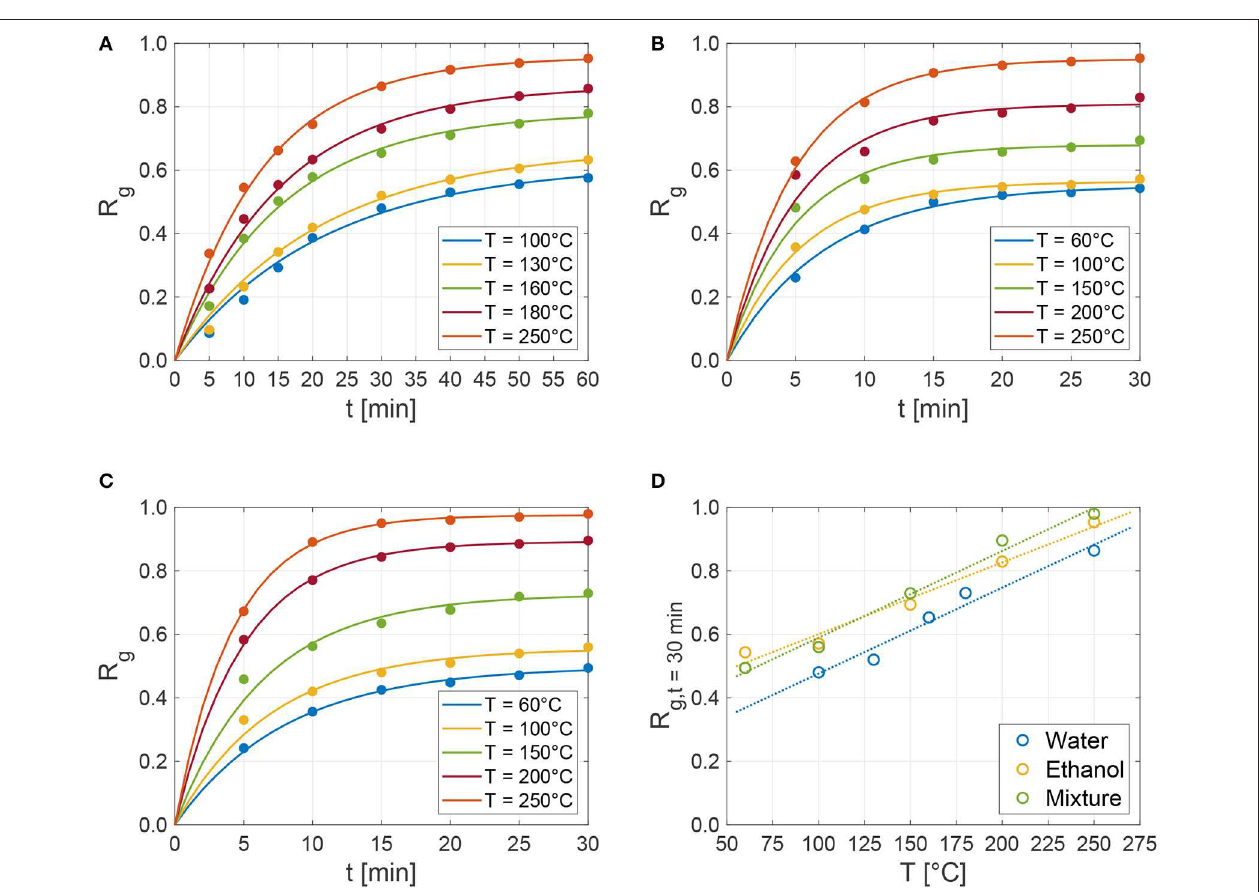
FIGURE 3 | Regeneration grade ( R g in Equation 2) as a function of time obtained by the experimental characterization tests on the 13X zeolite samples at different controlled temperatures for (A) distilled water, (B) ethanol, and (C) 30:70%wt. ethanol-water mixture. The dots correspond to the experimental data points, while solid lines show the best-fit of Equation (5). (D) Shows the regeneration grade measured at 30 min for the three tested fluids as a function of temperature (dots) and their linear fitting (dotted lines).